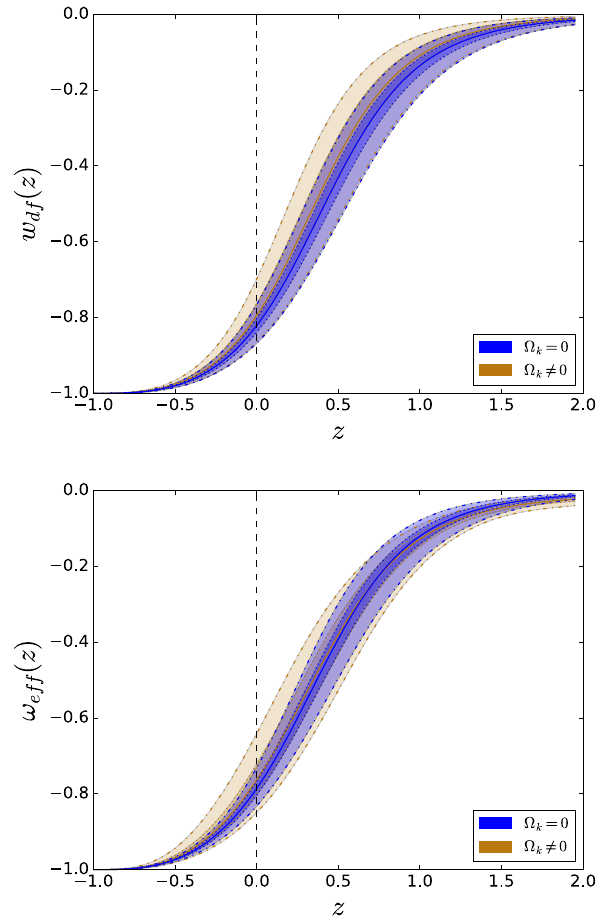
Fig. 3 Reconstruction of the equation of state for the dark fluid given by Eq. (3) (top panel) and the effective one (Eq. 13) (bottom panel) using the constraints from the joint analysis for both cases, flat (blue color) and non-flat (brown color) models. The uncertainty bands refers to 68% (inner band) and 99 . 7% (outermost band) CL